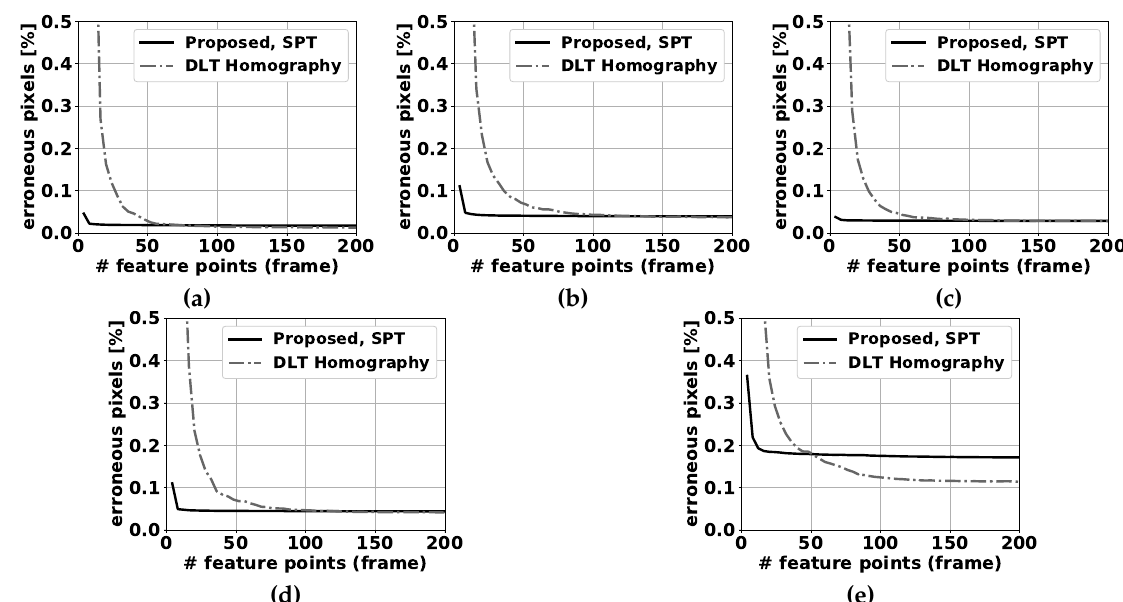
Figure 7. Percentage of erroneous pixels in variable tilt sequences where feature points are selected by using the algorithm described in [38]. The proposed panning for simultaneous pan and tilt (SPT) method is compared to the DLT homography method [24] for 5 sequences: ( a ) pure tilt, ( b ) equal pan and tilt, ( c ) random pan/tilt (slow), ( d ) random pan/tilt (medium), ( e ) random pan/tilt (fast). Please note that the number of erroneous pixels is significantly above 0.5% of the total number of pixels for a low number of feature correspondences, and cannot be clearly depicted on these